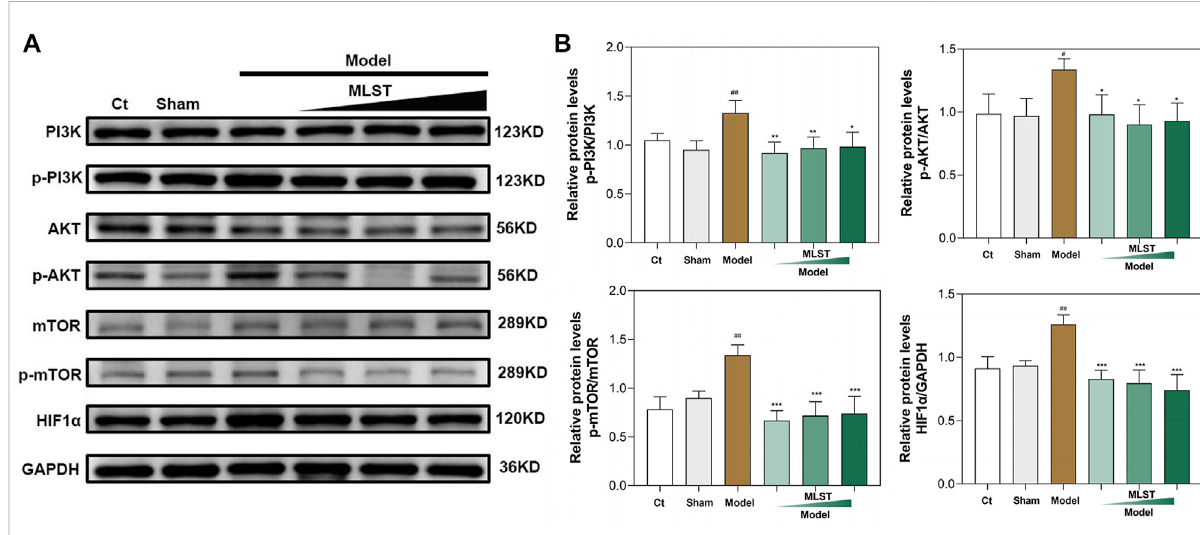
FIGURE 8 ResultsofwesternblotsanalysisofproteinexpressionofPI3K/AKT/mTORpathways. (A) RepresentativeblotresultsofPI3K,p-PI3K,AKT,p-AKT, mTOR,p-mTOR, and HIF-1 α . (B) Quantitativeanalysis ofwestern blots forp-PI3K/PI3K, p-AKT/AKT, p-mTOR/mTOR,andHIF1 α /GAPDH;N =6; # p < 0.05, ## p < 0.01, ### p < 0.001 compared to Ct; * p < 0.05, ** p < 0.01, *** p < 0.001 compared to